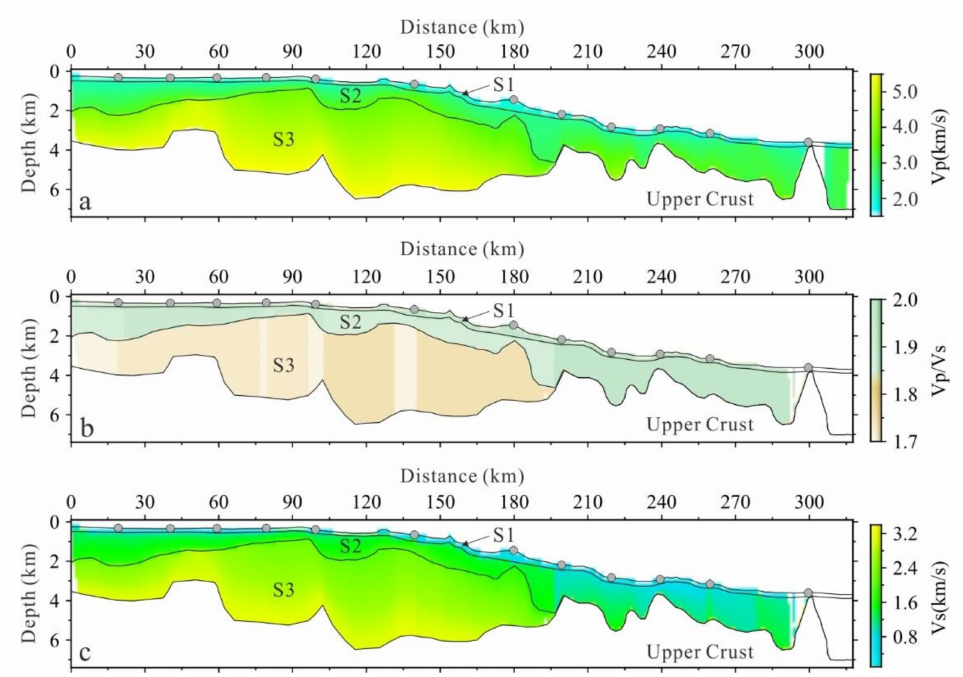
Figure 7. ( a ) P-wave velocity model, ( b ) Vp/Vs model, ( c ) S-wave velocity model of sedimentary layers. S1, S2 and S3 represent sedimentary layers 1, 2, and 3,